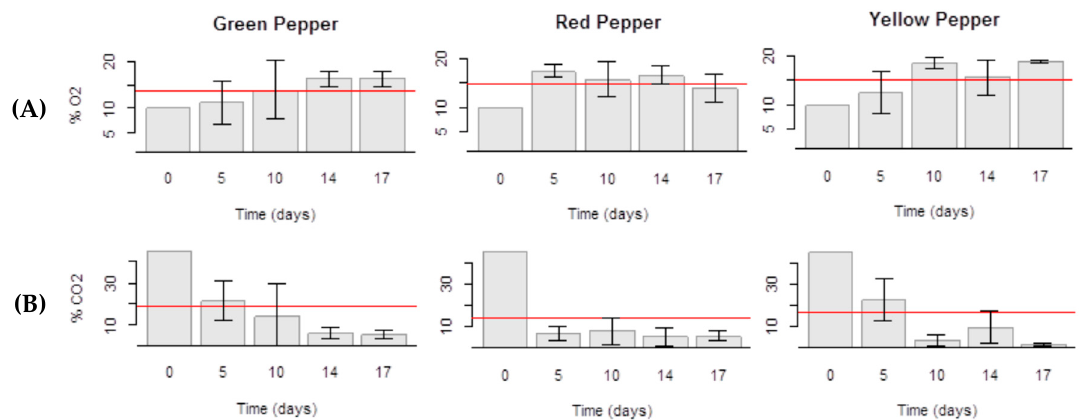
Figure 1. Evolution of the atmosphere gas composition inside the package (( A ) % O 2 ; ( B ) % CO 2 ) of fresh-cut bell peppers (green pepper; red pepper; yellow pepper) stored under an initial MAP condition of 10% O 2 and 45% CO 2 throughout 17 days at 5 °C. The statistical mean is represented by the horizontal line.